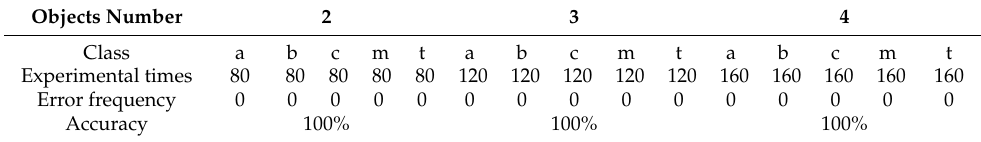
Table 7. Sorting order reasoning